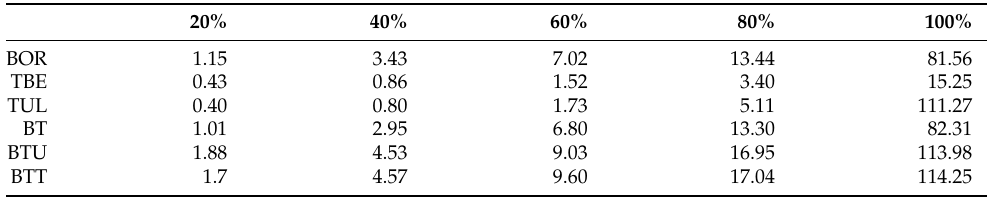
Table A1. Twenty percent quantiles of non-zero incidence ( number of cases per 100,000 ) for BOR, TBE, TUL, BT, BTU, and BTT for the 1985–2015 period. (The district Ahvenanmaa with values BOR (1253), TBE (37), and TUL (0.36) was